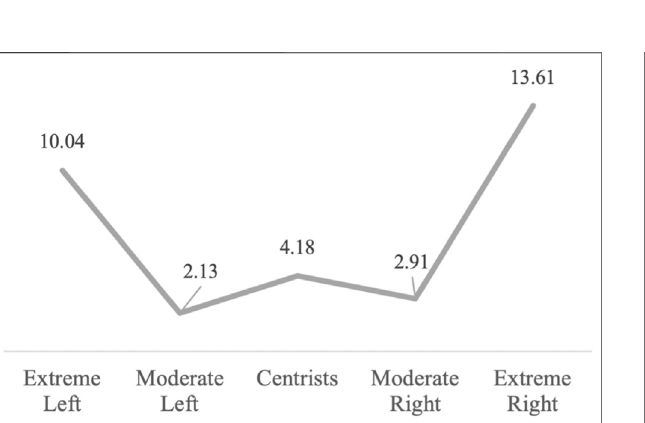
FIGURE 3 | Predicted Probabilities of Being Extremely Xenophobic by PoliticalIdeology.Source:EuropeanSocialSurvey,cumulativedataset,waves 1 – 9. Own